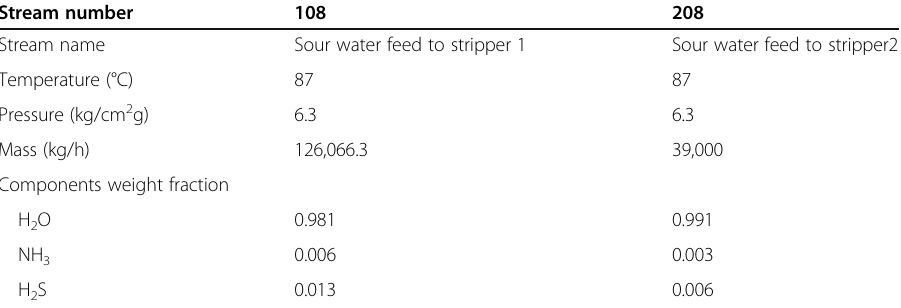
Table 1 Sour water feed characteristics to stripper1 and stripper2 Stream